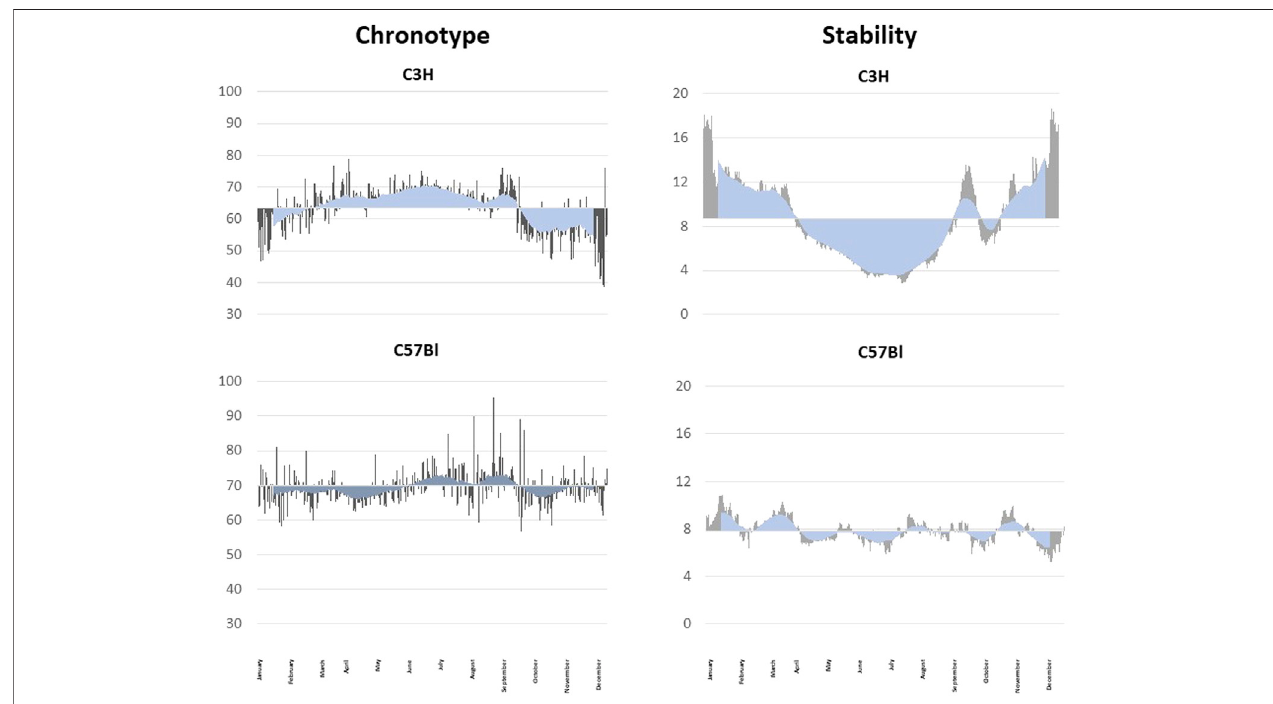
FIGURE 3 | Seasonal fl uctuation of the chronotype and the rhythm stability. Analyses of seasonal fl uctuations of the daily chronotype and the rhythm stability of a C3H (uppergraphs)and aC57Blmouse(lowergraphs)undersemi-naturalconditionsfor1 year.Thedailymeasurementsareshownasgreylines,thebluelinesindicate the rolling average over 30 days. The data are blotted against the yearly mean. The melatonin-pro fi cient C3H mouse show a clear seasonal difference in the chronotype with a later, more stable chronotype in summer and an earlier, less stable chronotype in winter. The melatonin-de fi cient C57Bl mice did not show pronounced seasonal changes in the chronotype and has variable stable and unstable